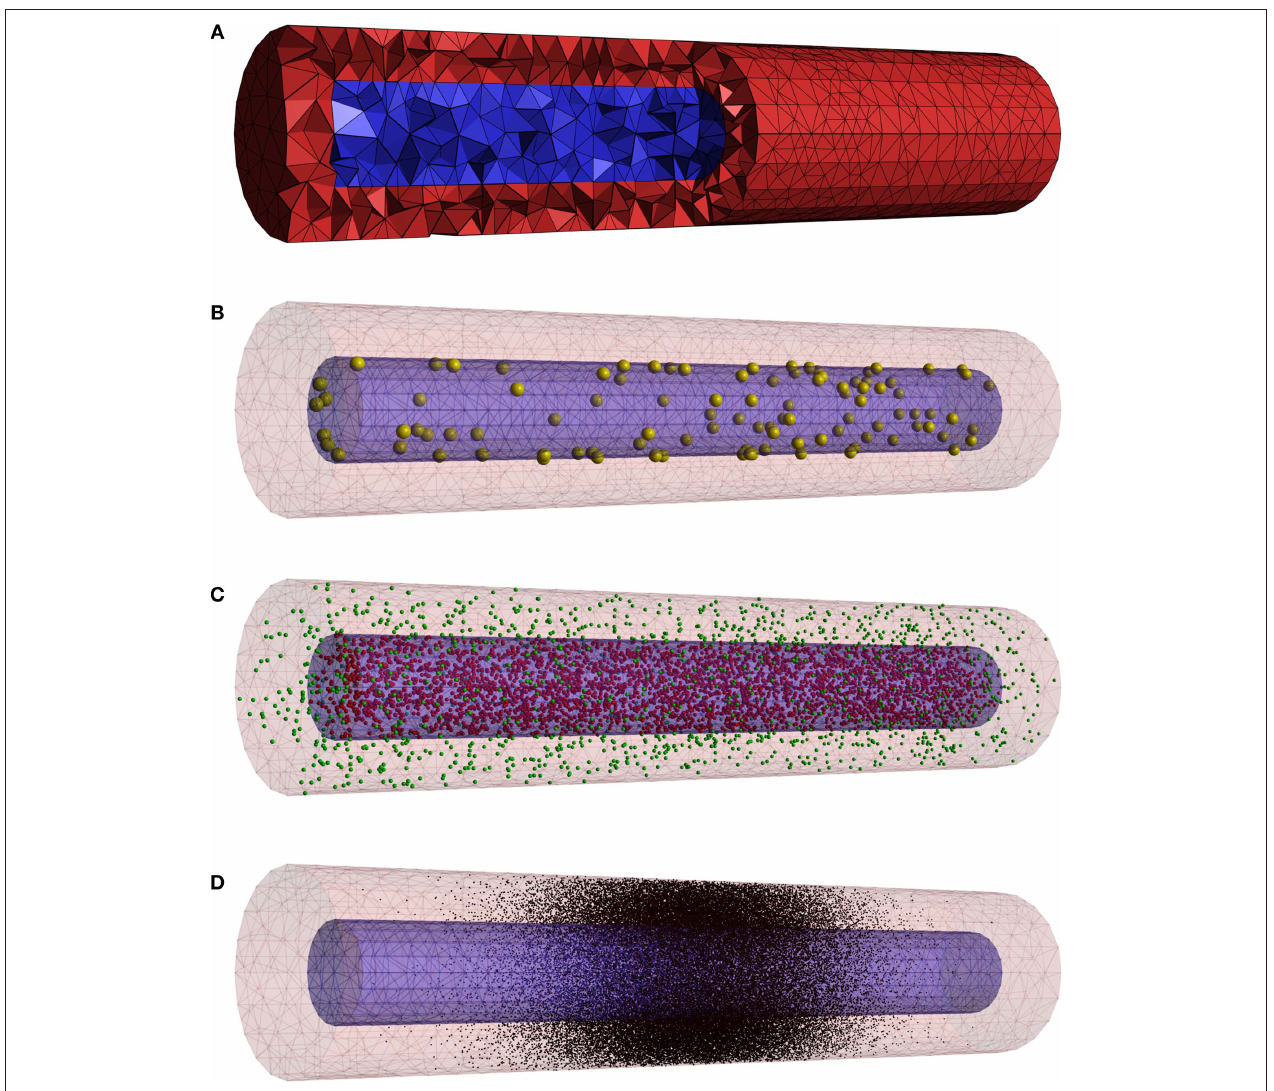
FIGURE 3 | The mesh used in the code examples for setting up initial conditions. (A) This opaque view with a cut-out shows that 21090 tetrahedons are used to describe one cylinder surrounding another one. (B) Membrane channels C are distributed randomly over the inner membrane. (C) A uniform initial distribution for molecules A and B . (D) A Gaussian distribution in the center of the outer cylinder for X